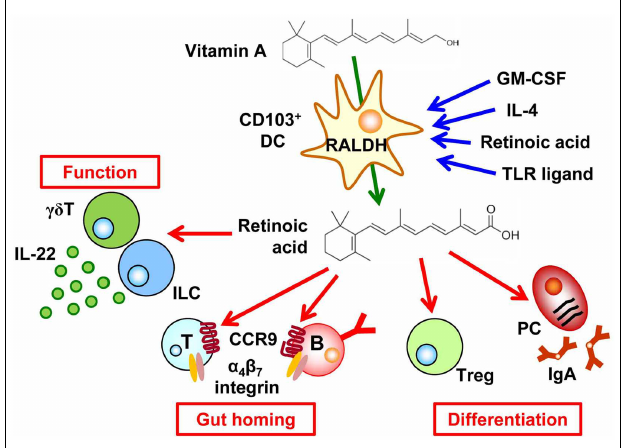
FIGURE 1 | Regulation of cell trafficking, differentiation, and function by the vitaminA metabolite retinoic acid . CD103 + dendritic cells (DCs) express retinaldehyde dehydrogenases (RALDH) by GM-CSF, IL-4,TLR ligand, and retinoic acid (RA), which enable them to convert vitamin A into RA. RA then induces CCR9 and α 4 β 7 integrin inT and B cells, causing them to migrate into the intestine. In addition, retinoic acid affects cell differentiation, such as the preferential differentiation ofT cells into regulatoryT (T reg ) cells and B cells into IgA-producing plasma cells (PCs). RA also enhances IL-22 production from γδ T cells and innate lymphoid